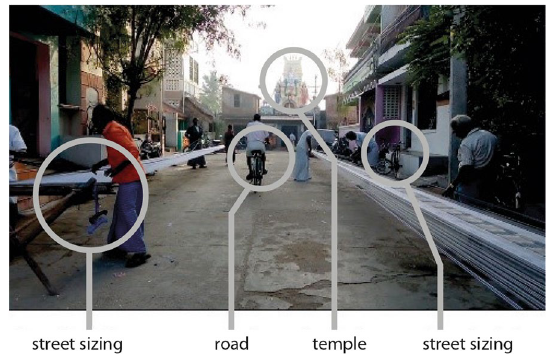
Fig. 6 Street-level activities in the weavers’ zone (Source: the author)